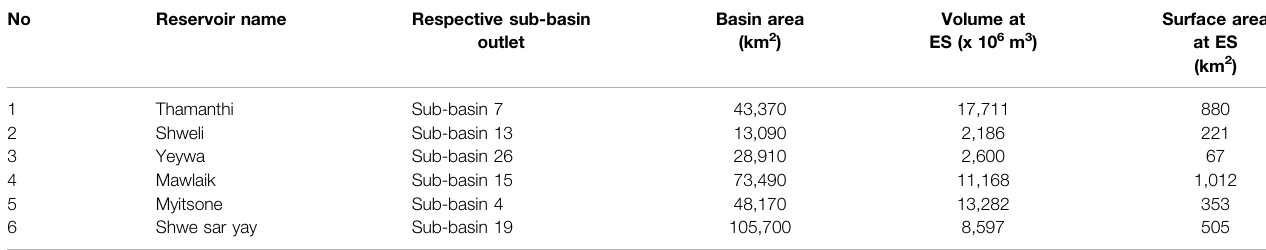
TABLE 3 | Basic characteristics of the planned reservoirs considered in this